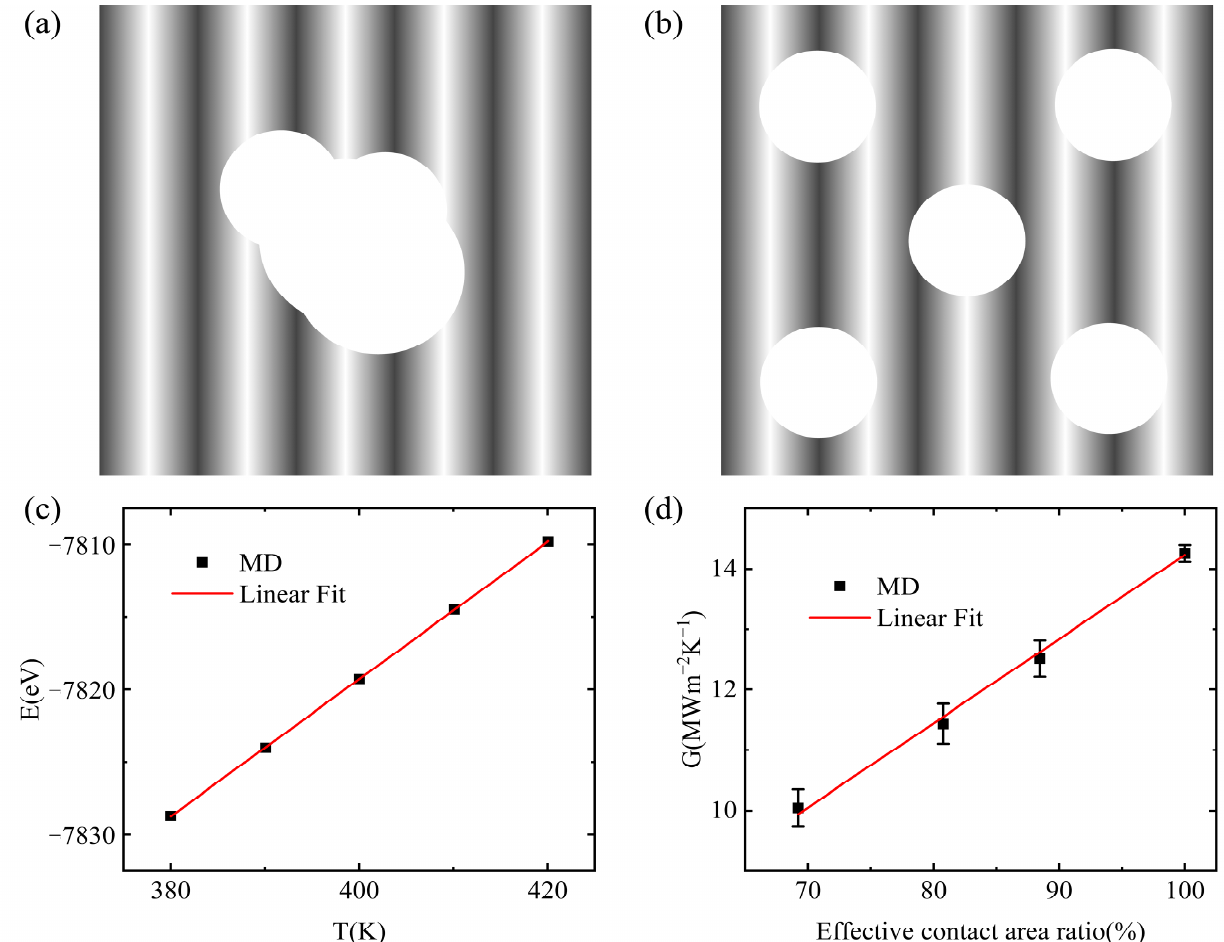
Figure 6. ( a ) Top view of single vacuole model. ( b ) Top view of multiple vacuole model. ( c ) The heat capacity of silicon at 400 K is calculated and linearly fitted by calculating the relationship between temperature and energy. ( d ) The relationship between the interfacial thermal conductance of a multiple vacuole model at 500 K and the effective contact area ratio.